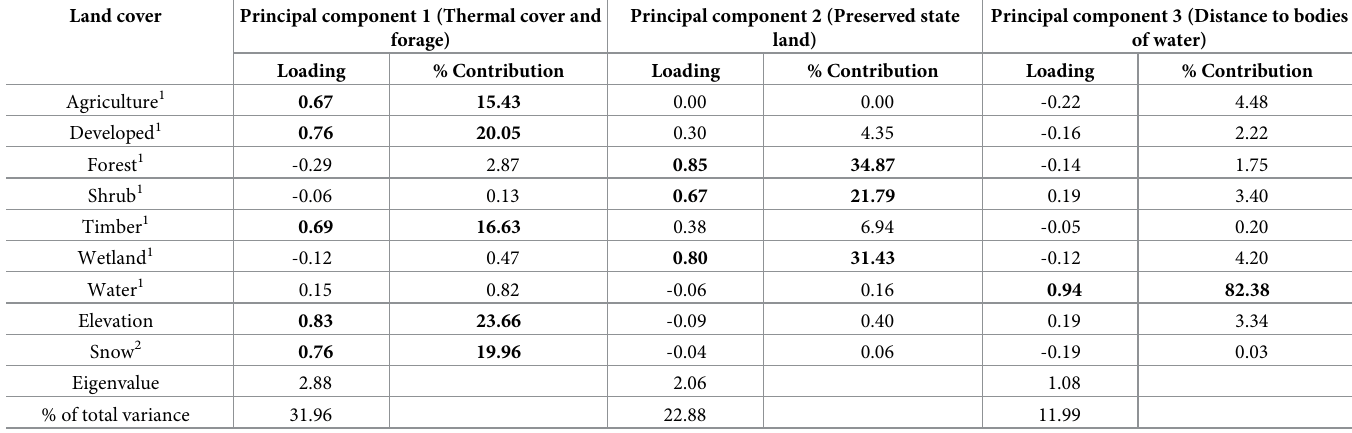
Table 3. Factor loadings and percent contribution for each of the top 3 principal components (PC) for land cover measured across the Adirondack Park, New York. Land cover